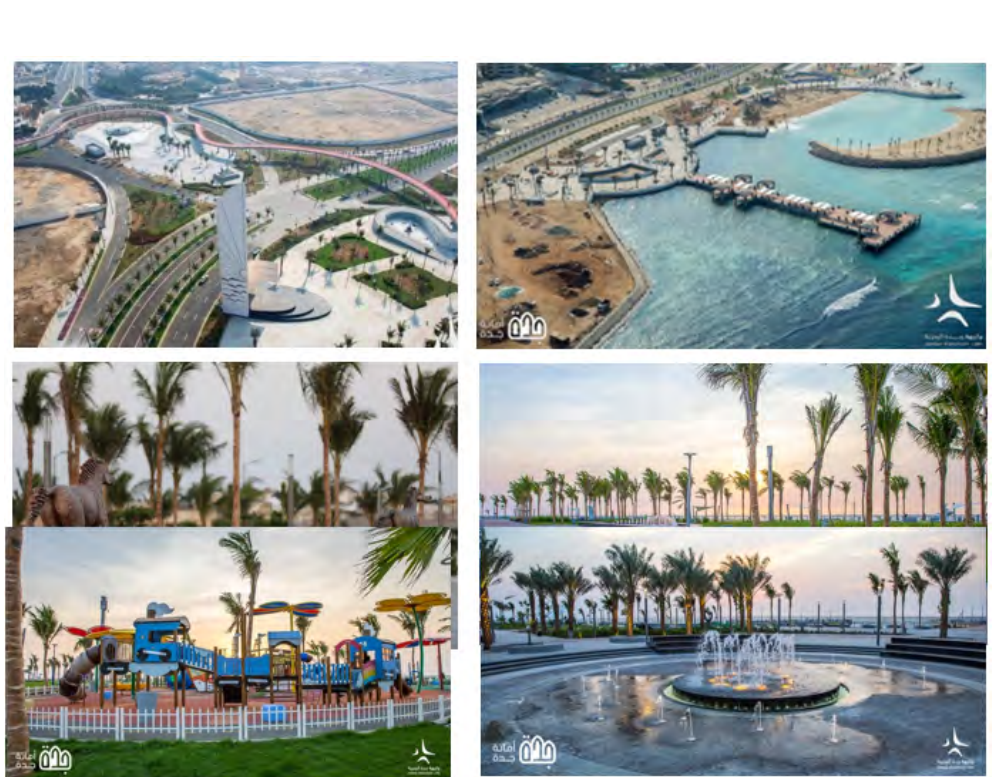
Figure 4. Different Views of NJW Source: Jeddah Municipality,